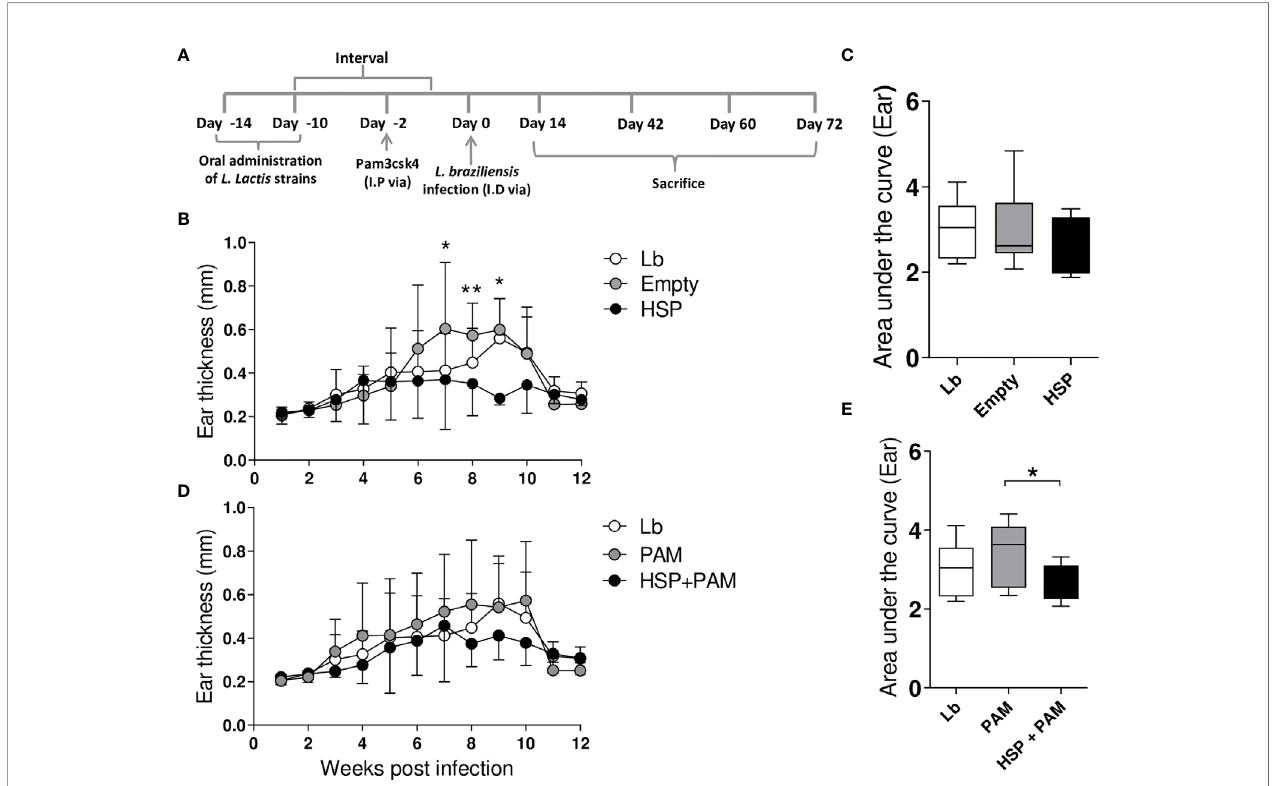
FIGURE 1 | Experimental design and lesion development. Mice were treated with water (Lb and PAM), GM17 Medium containing empty vector-bearing L. lactis (Empty) or XM17 medium containing Hsp65-producing L. lactis (HSP and HSP+PAM) for 4 consecutive days, then infected with L. braziliensis metacyclic promastigotes via inoculation in the ear 10 days later. Two days prior to infection, the HSP+PAM and PAM groups received an intraperitoneal administration of PAM3CSK4. Lesion course was measured weekly using digital caliper. (A) Schematic drawing of the experimental protocol in BALB/c mice. (B, C) Ear thickness and area under the curve in Lb, Empty and HSP groups. The area under the curve was constructed using ear measurement data from each group. (D, E) Ear thickness and area under the curve of Lb, HSP+PAM and PAM groups. (B, D) Data are representative of means ± SD. (C, E) Data are representative of medians and interquartile range. Data are representative of four independent experiments using 10 animals per group. For nonparametric data, Kruskal-Wallis with Dunn ’ s post- test was used. (*) indicates P < 0.05 and (**) indicates P < 0.01 between Empty and HSP groups at 7, 8 and 9 weeks in (B)